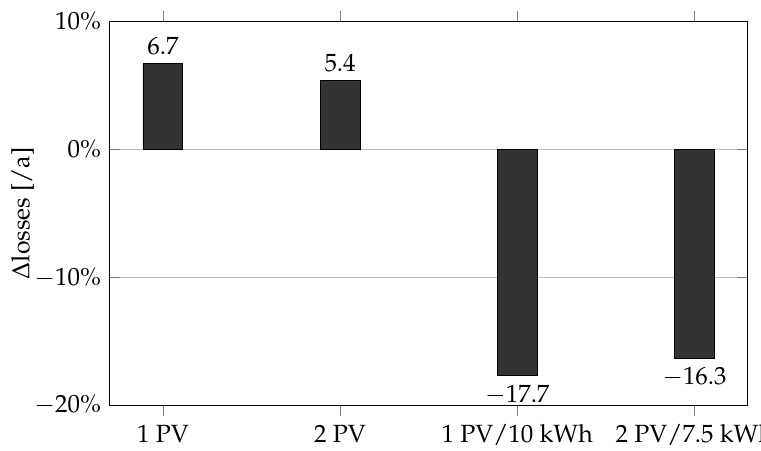
Figure 11. Relative changes in annual losses during DC operation with various PV and battery system configurations. The ∆ -comparison is with reference to AC performance; thus, positive values indicate higher losses during DC operation.